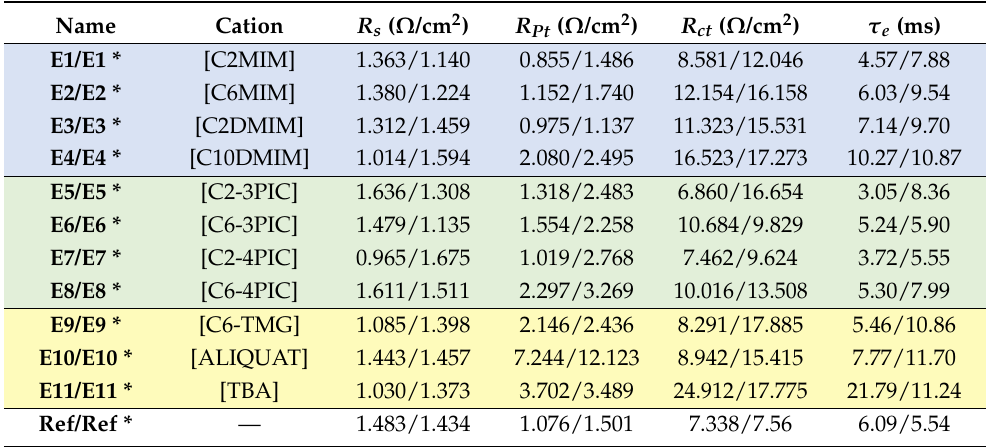
Table 4. EIS parameters for the test cells employing the various iodide-based organic salts as additives, with (*) and without 4-TBP, obtained from the Nyquist plots.